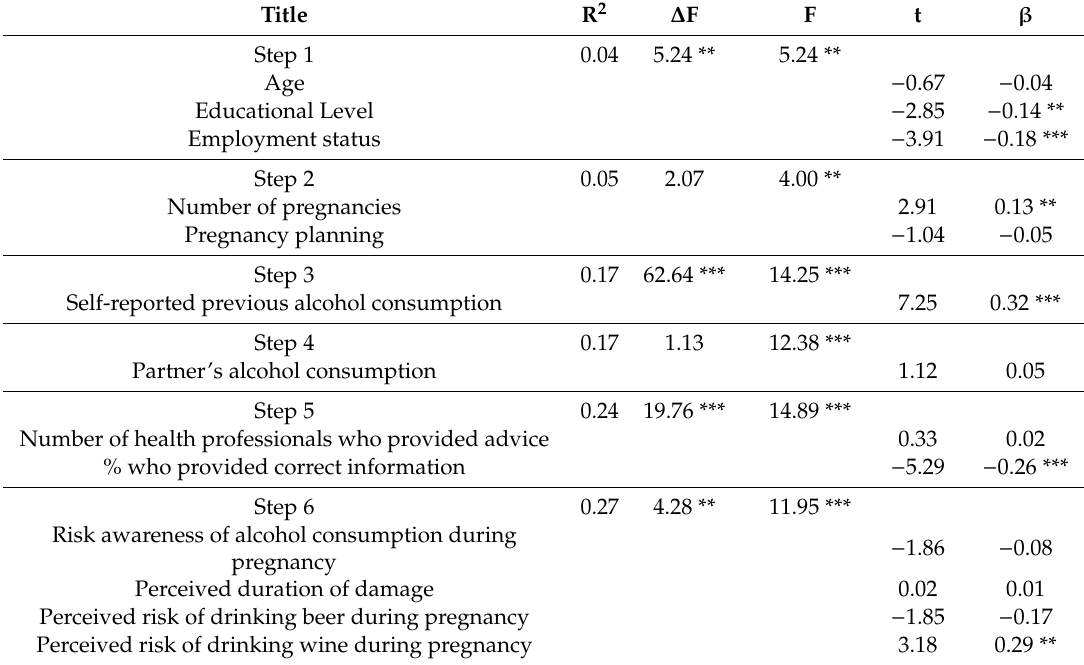
Table 2. Hierarchical regression analysis of demographics, obstetric history, previous alcohol consumption, the partner’s alcohol consumption, advice received from health professionals, and beliefs about risks, as correlates of alcohol consumption during